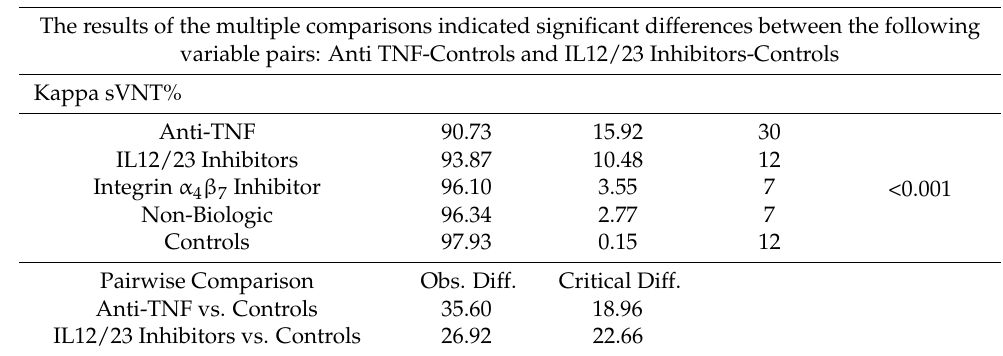
Table 2. Cont. Variable Levels Mean SD n p